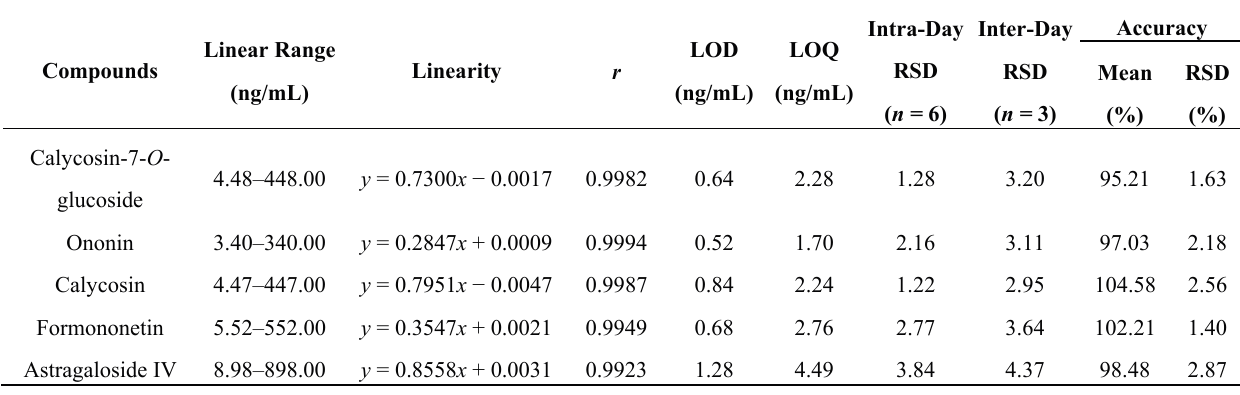
Table 2. Method validation for the determination of calycosin-7- O -glucoside, ononin, calycosin, formononetin and astragaloside IV.